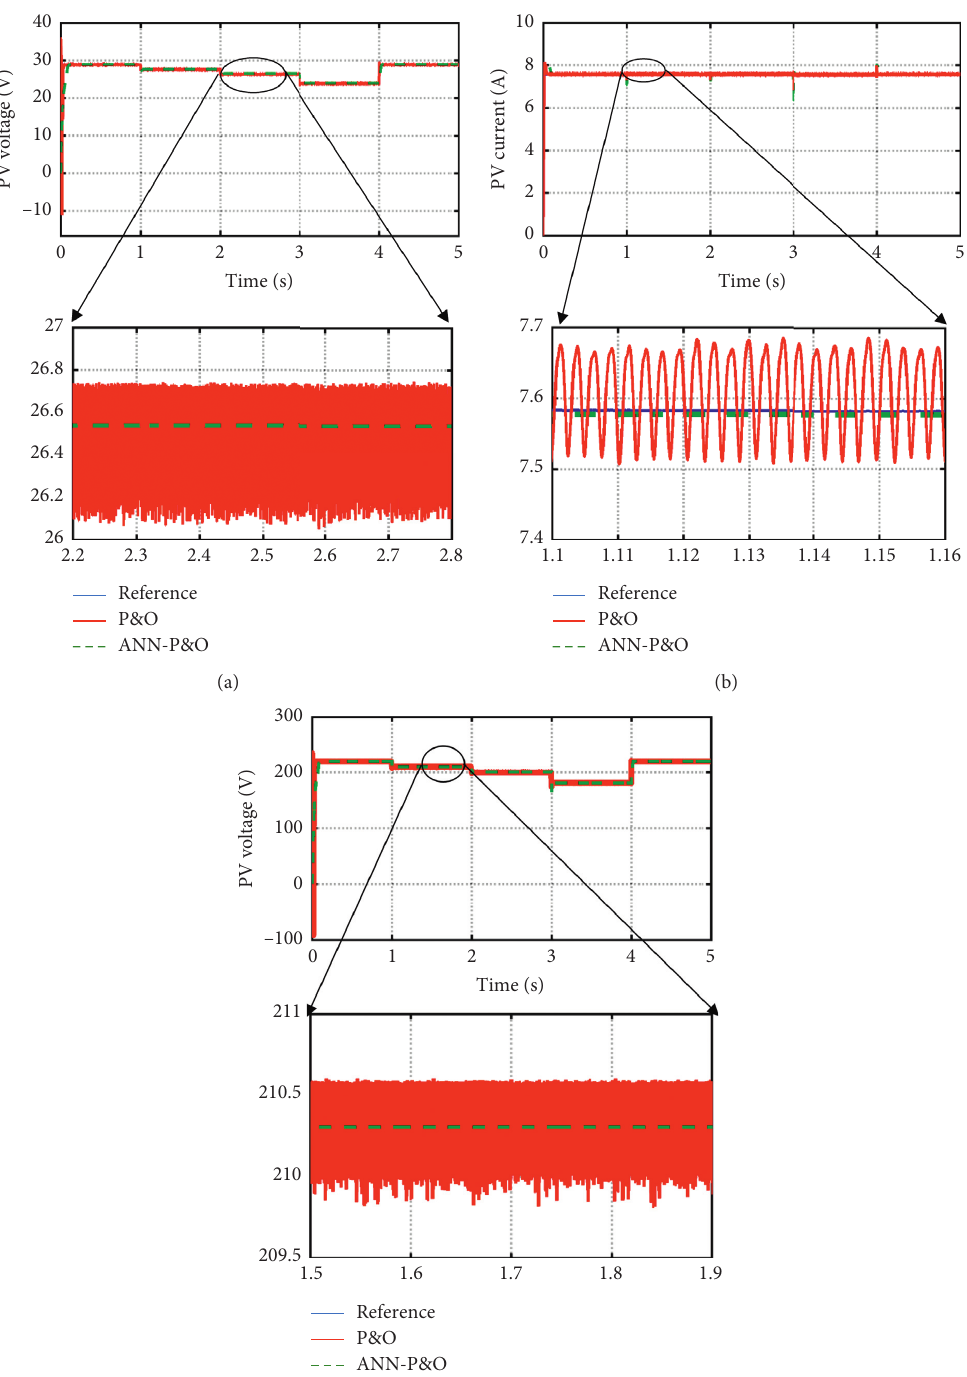
Figure 13: PV simulation responses under varying temperature. (a) Voltage. (b) Current. (c)